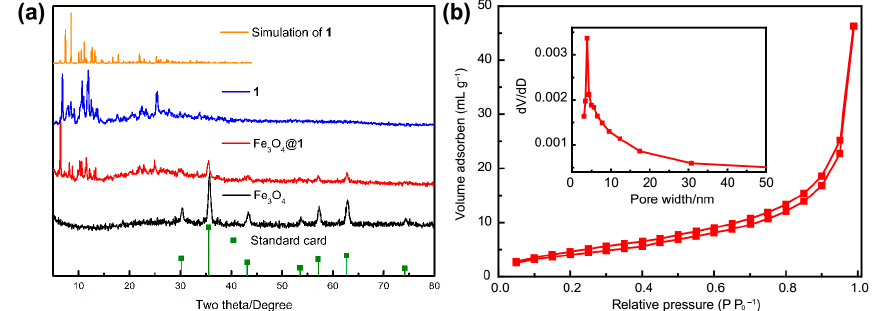
Figure 7. ( a ) The XRD diffraction analyses, ( b ) N 2 adsorption-desorption curve. Inset figure: aperture distribution curve of Fe 3 O 4 @ 1 .